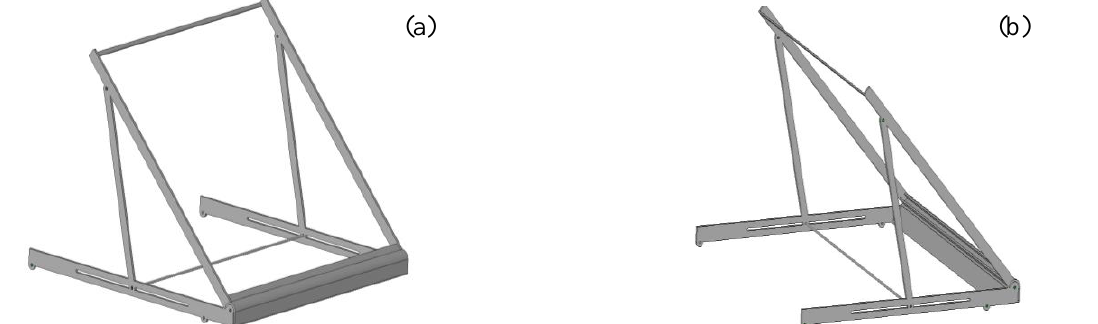
Figure 4. 3D first-angle (a) and third angle (b) isometric model of the proposed solar photovoltaic tilting